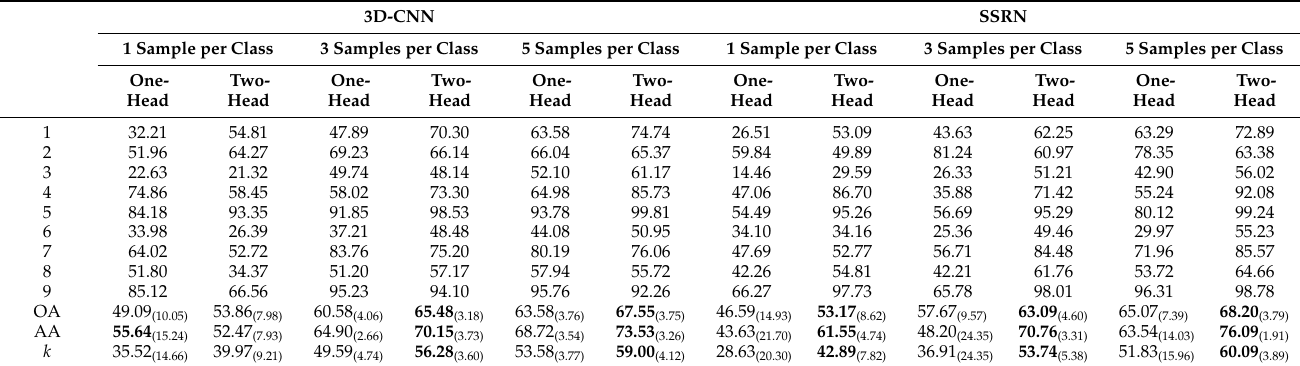
Table 13. Classification accuracy (%) of the proposed two-head network and the comparison one-head network. The experiment is conducted with one, three and five training samples per class on the PaviaU dataset.